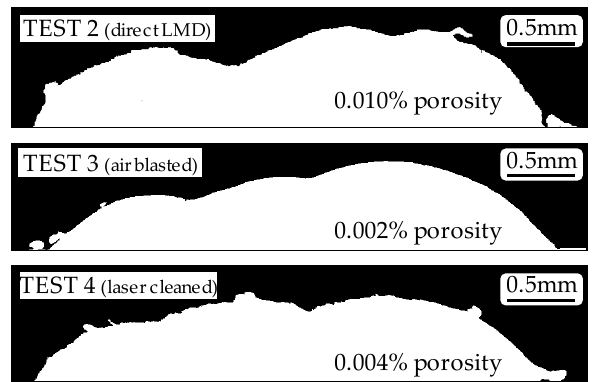
Figure 4. Tests No. 2, 3 and 4—5% concentration cutting fluid tests results. Coatings 2018 , 9 , x FOR PEER REVIEW